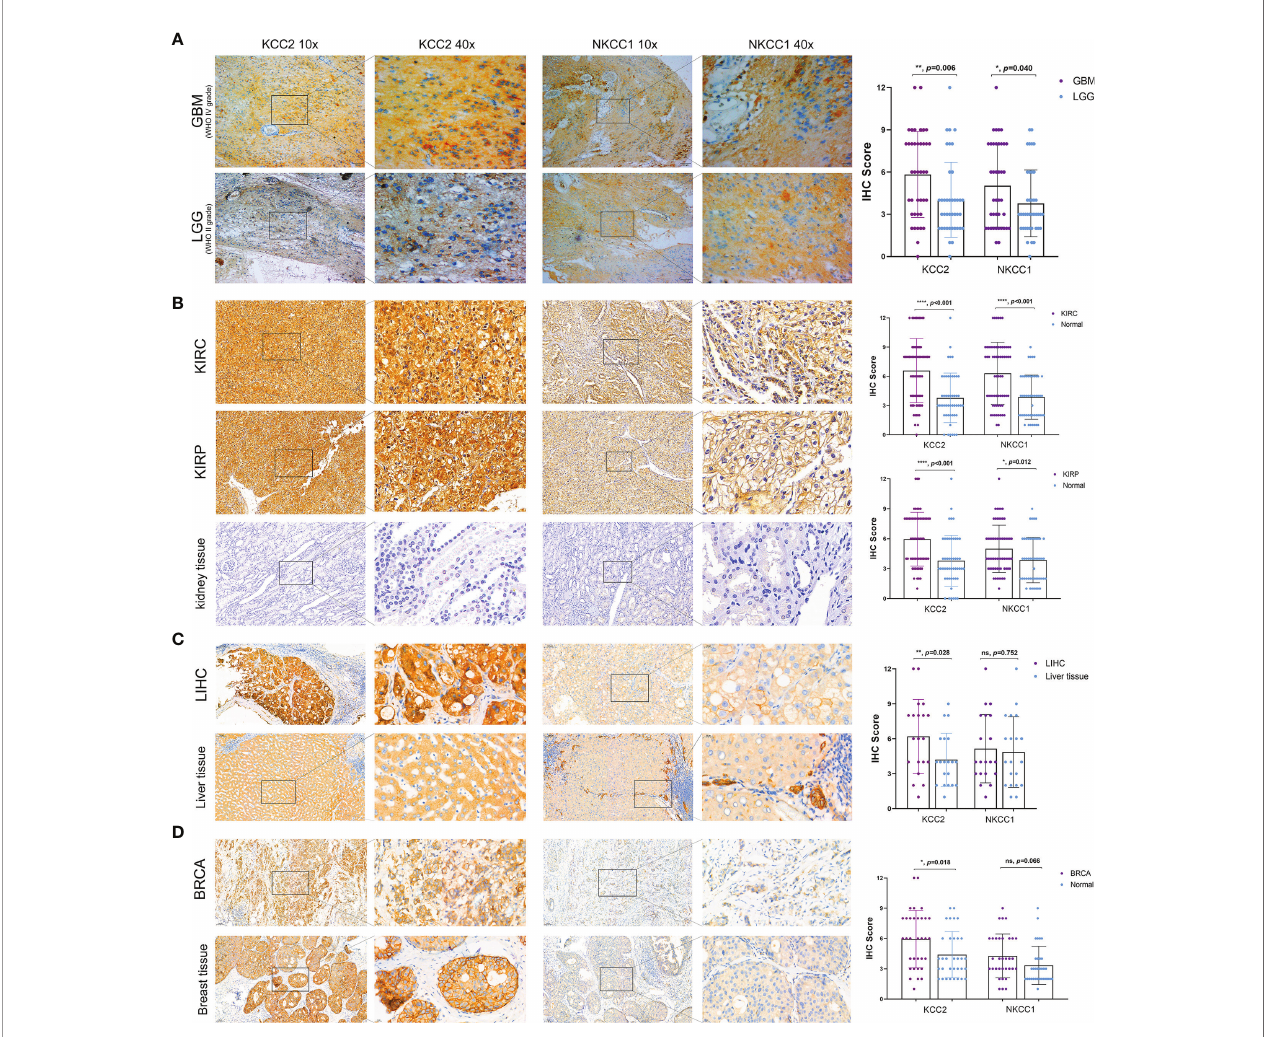
FIGURE 11 | Signi fi cantly altered protein expression of KCC2 and NKCC1 based on three real-world cohorts (AHYMUN, FUSCC, and PHZU cohorts). (A) KCC2 and NKCC1 expression was signi fi cantly elevated in 40 GBM (WHO IV Grade) compared with 40 LGG (WHO II Grade) samples from the AHYMUN ( p < 0.05). (B) In 70 clear cell renal cell carcinoma (KIRC), 50 papillary cell renal cell carcinoma (KIRP), and 50 normal kidney tissues from FUSCC cohort, KCC2 and NKCC1 expression were signi fi cantly elevated in kidney tumors compared with normal tissues ( p < 0.05). (C) We compared 20 paired liver cancer and normal samples from PHZU cohort, and found signi fi cantly elevated KCC2 expression ( p = 0.028) and insigni fi cant expression difference of NKCC1 expression ( p = 0.752) in liver cancer samples “ ns ” represents “ not signi fi cant ” . (D) The expression of KCC2 was signi fi cantly higher in 33 breast cancer tissue than in normal tissues ( p = 0.018). *p < 0.05, **p < 0.01, ***p <